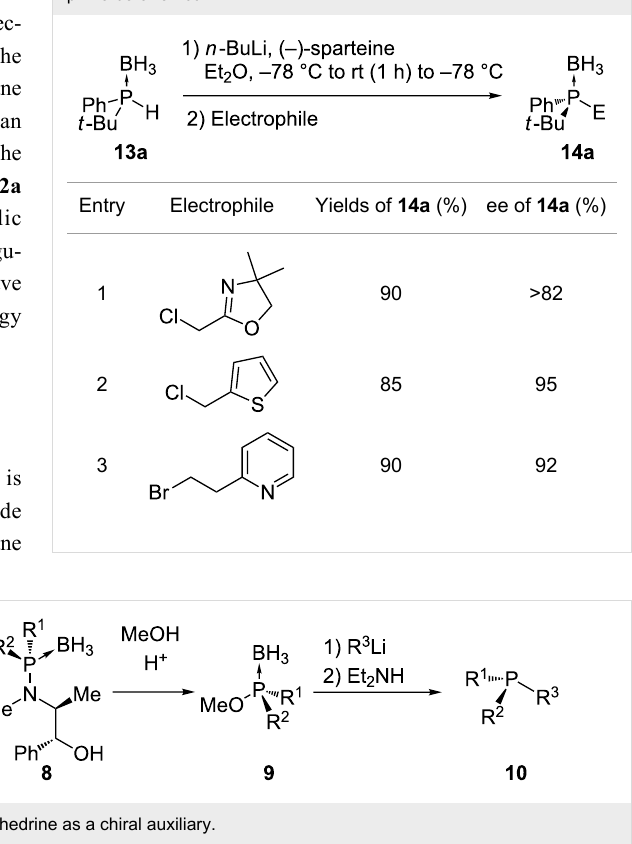
Table 1: Alkylations of dynamically resolved tert -butylphenylphos- phine borane 13a .